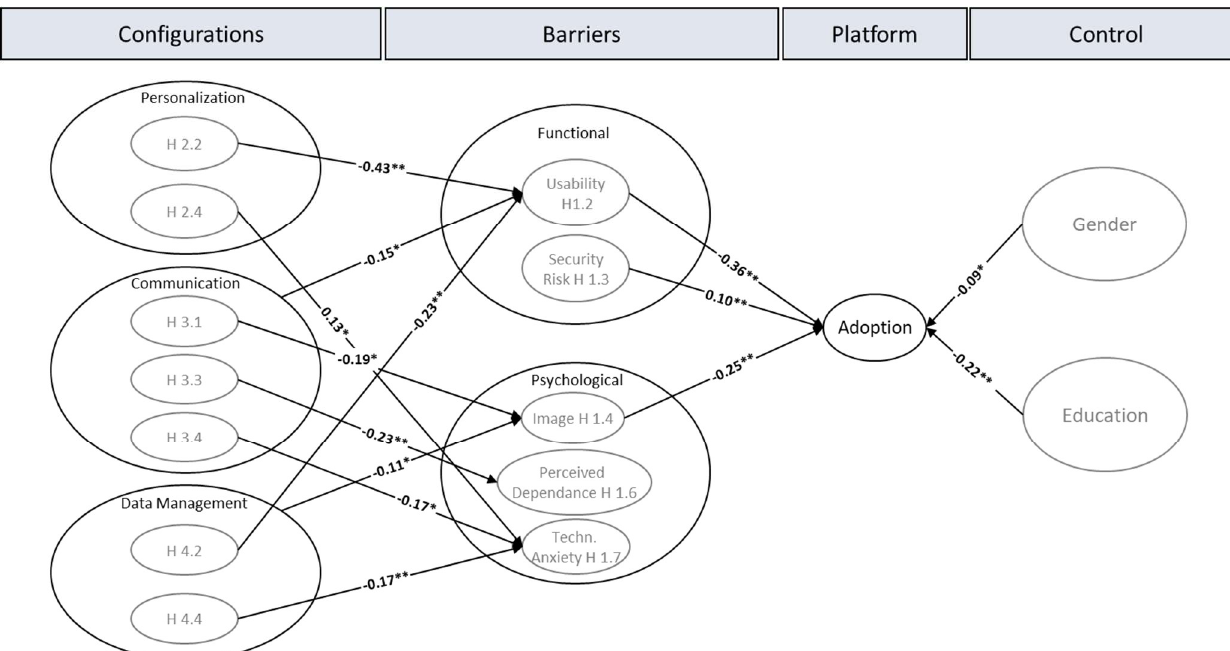
Figure 2. Significant factors in the adoption Model for digital platform services to manage the COVID-19 vaccination. Notes: ** p < 0.01, * p < 0.05.